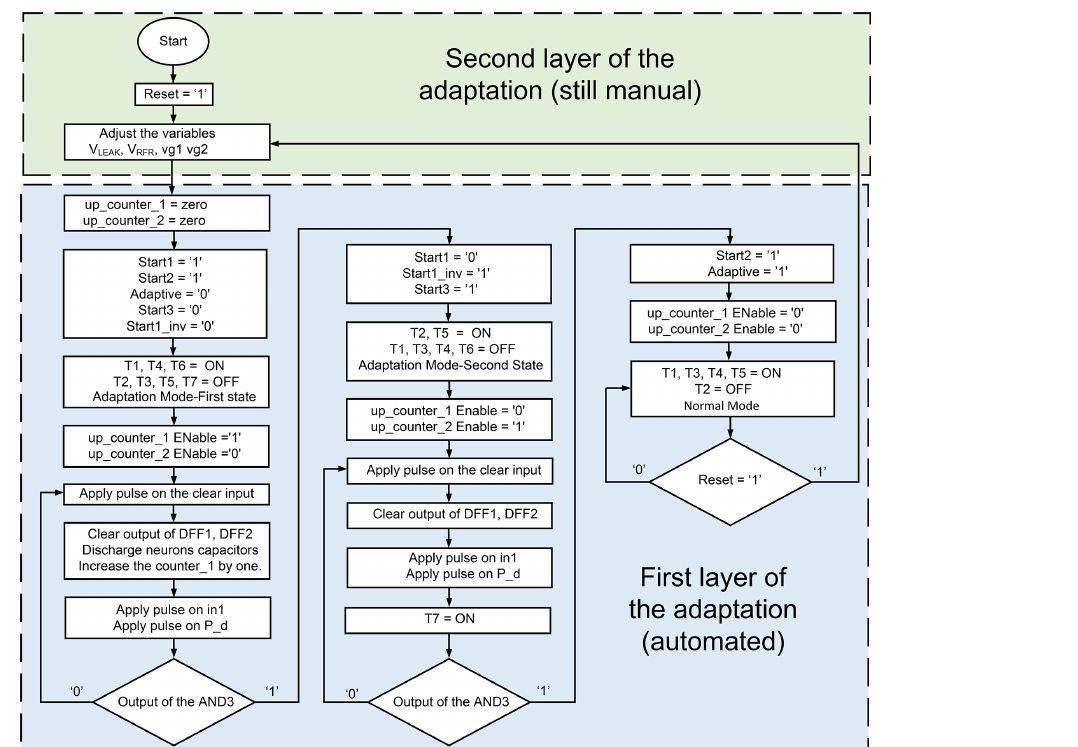
Figure 11. Flow diagram of the adaptation layers’ hierarchy. The first layer represents the adaptation work of adaptive ACD. The up_counter_1 and up_counter_2 save the 8bit binary digitized transistor of the first and second synapses, respectively. Start1, Start1_inv, P_d, Start2, Start3, Adaptive, and Clear are signals used inside the control circuit of adaptive coincidence detection